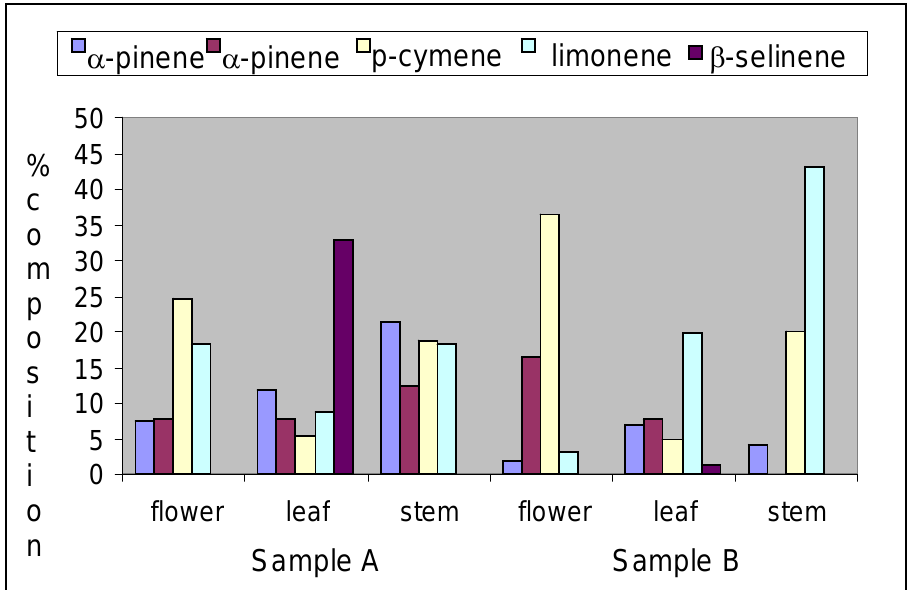
Figure 2. Major components of the flower, leaf and stem oils of Senecio polyanthemoides from two different